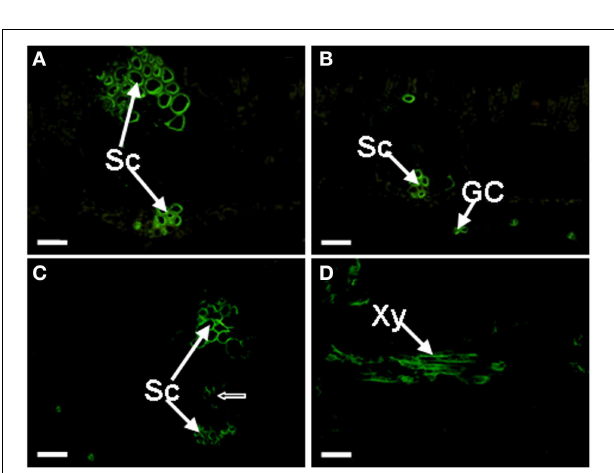
FIGURE 3 | Localization and distribution of AGPs recognized by JIM4, JIM14, JIM16, LM2, and LM14 antibodies in banana ( Musa spp. AAA) leaves. Cross-sections through the lateral vein are presented for all cases. (A) The JIM4 epitopes present in the phloem cells, showing a ring structure. (B) The JIM14 signal, mainly present in the vein, the sclerenchyma cells of the lower epidermis side, the phloem cells, and weak one also appeared in the mesophyll cells and the epidermal cells. (C) The JIM16 signal appeared in most cell types of the vascular bundle and the epidermal cells, showing a relatively stronger signal in the phloem.